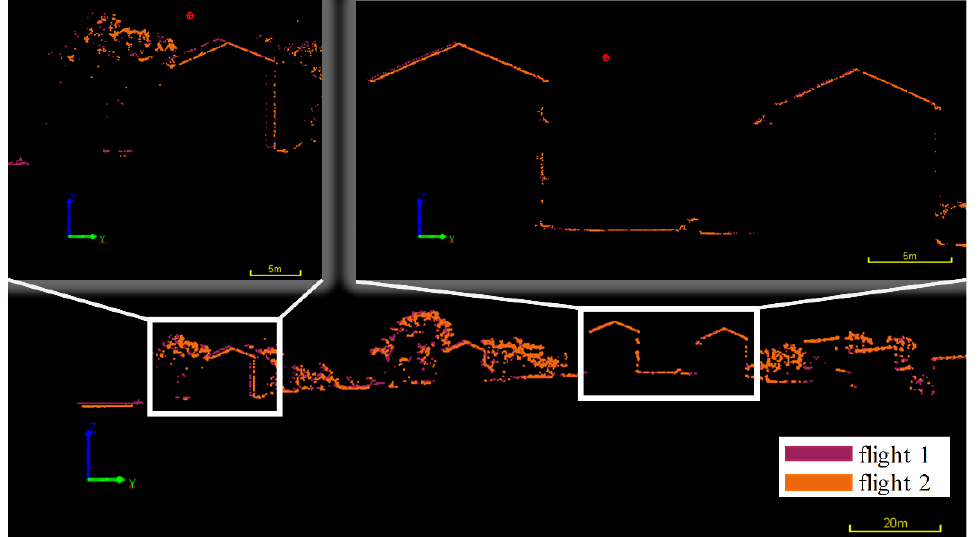
Figure 23. Vertical section of point cloud in opposing flight strips (flight 2 and flight 3) with instal- lation angle compensation.